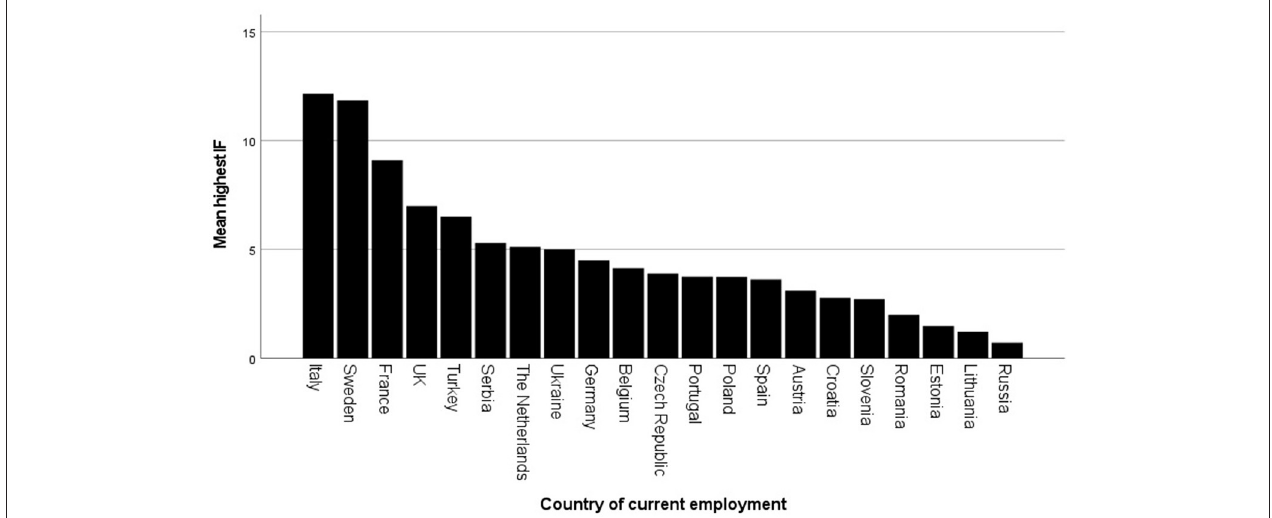
FIGURE 4 | Impact factor (IF, means) of best publication per country of